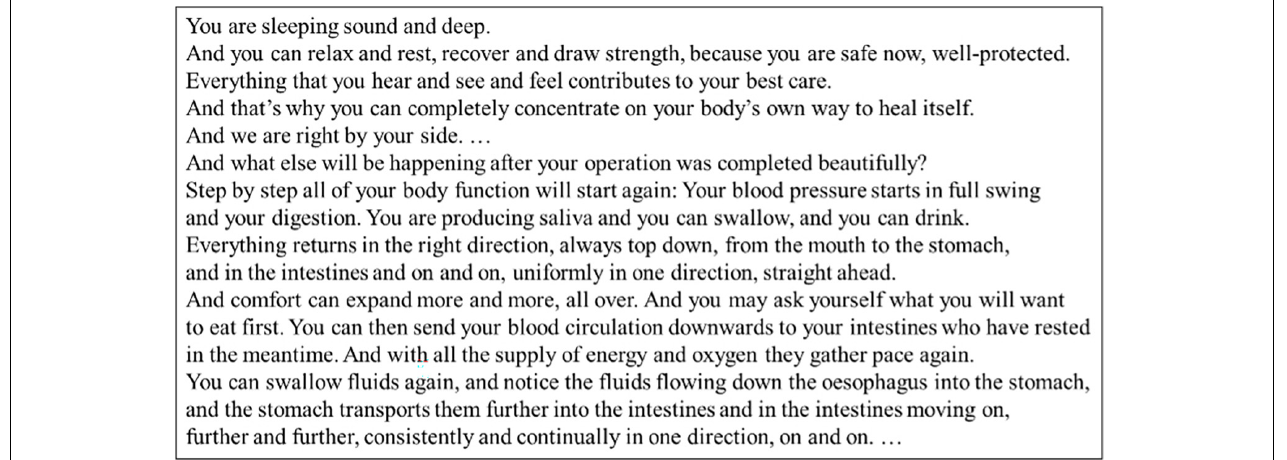
FIGURE 1 | Example text of the therapeutic suggestions used in this